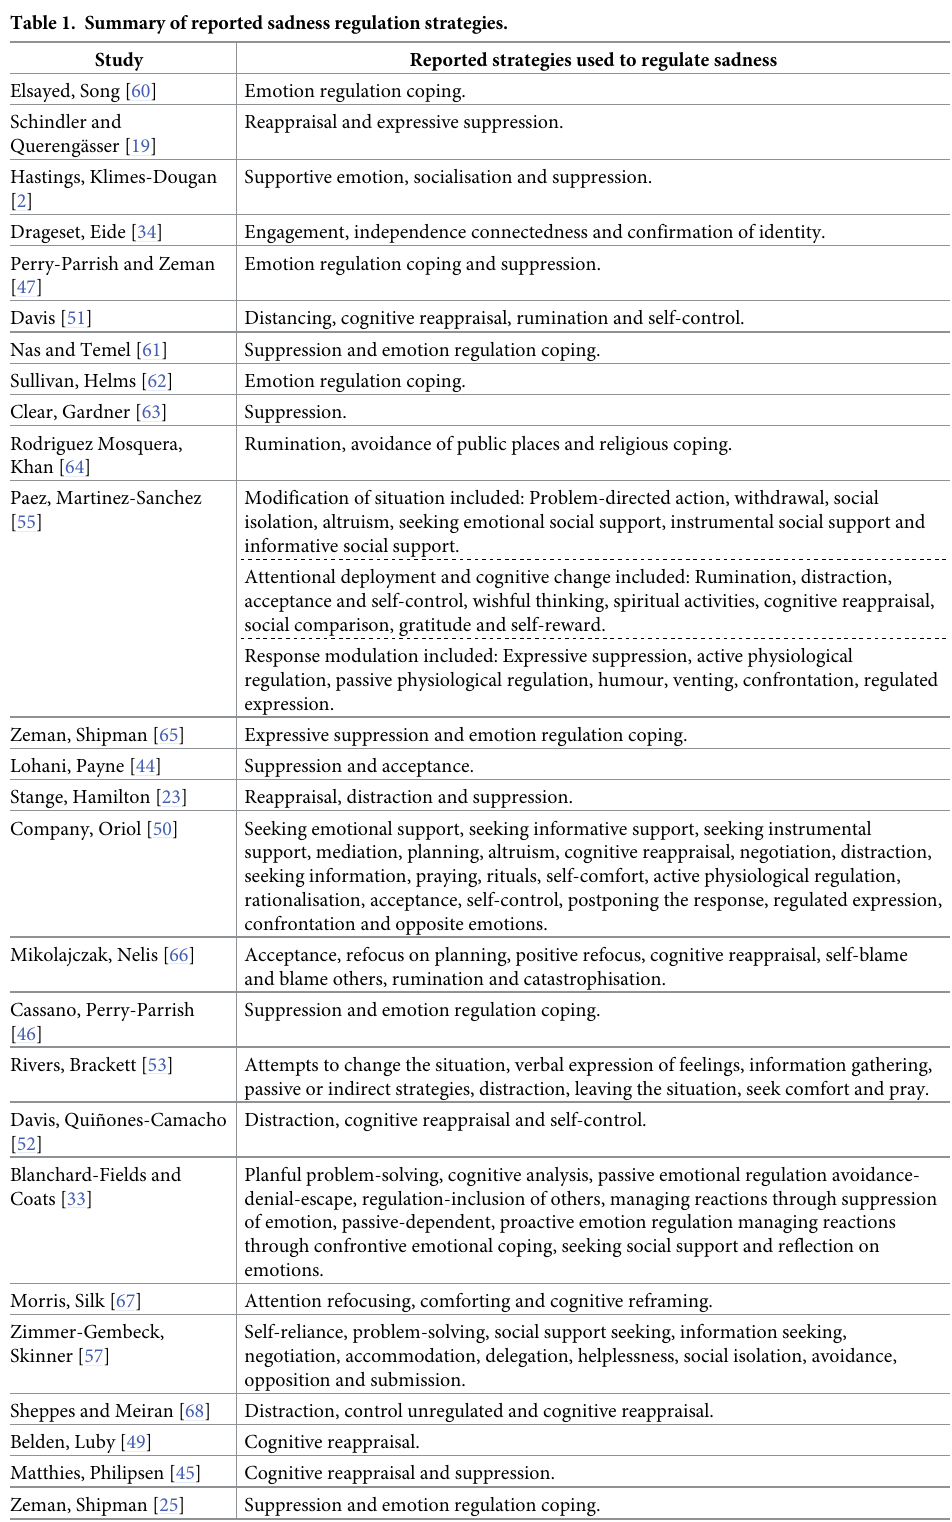
Table 1. Summary of reported sadness regulation